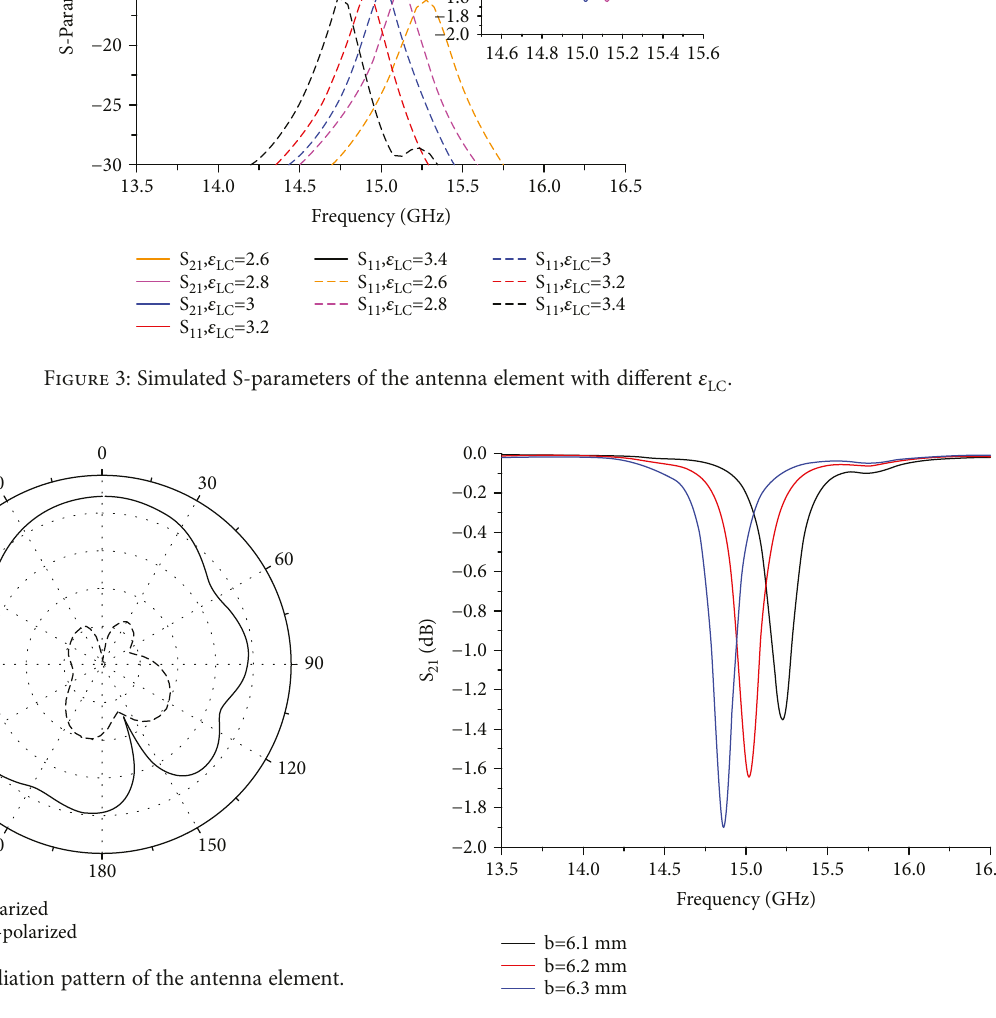
Figure 5: Simulated S parameters with di ff erent b 21